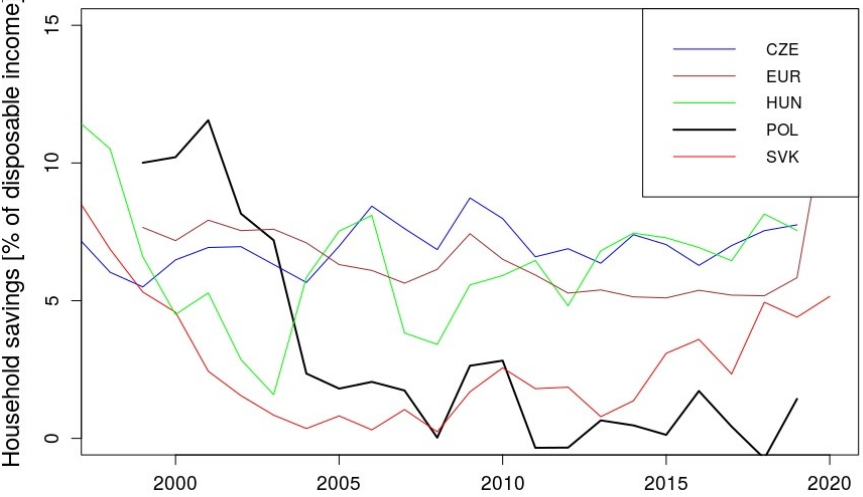
Figure 6. Economic situation of citizens (1998–2019): Household savings. Source: EUROSTAT [38].